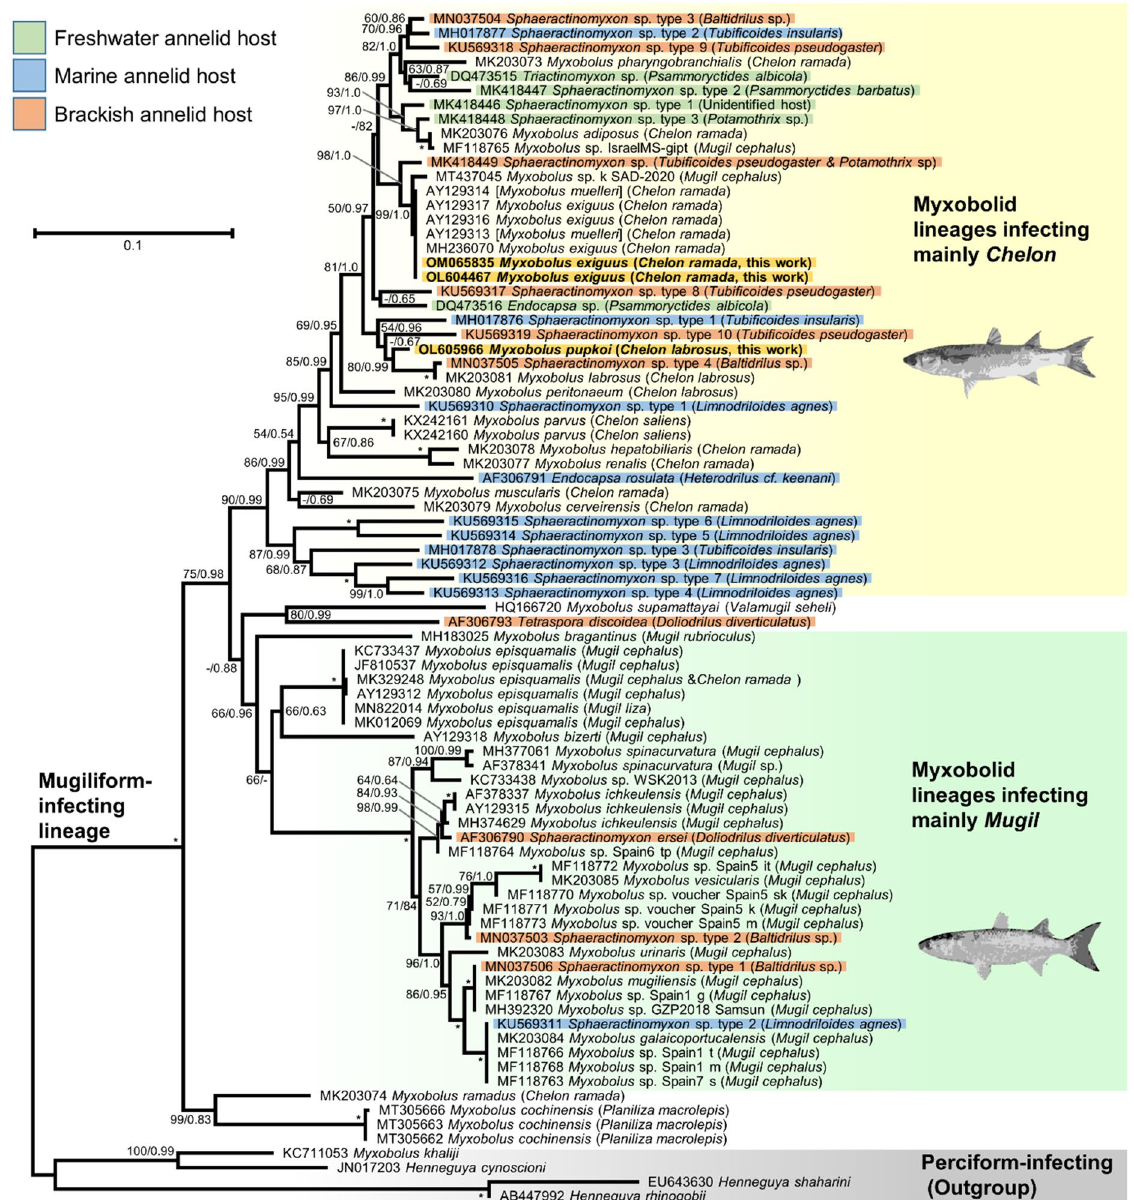
Figure 3. Phylogenetic relationships within the mugiliform-infecting lineage inferred from 18S rRNA sequences under the ML criterion (TVM + F + R3 model). The new sequences of M. exiguus (OL604467 and OM065835) and M. pupkoi (OL605966) are indicated in bold and with a yellow background. Branch supports (i.e. ML bootstrap percentages [BP] above 50/posterior probabilities [PP] above 0.5) are indicated near the corresponding nodes. Maximal support values (BP = 100/PP = 1.0) are indicated by an asterisk. A dash indicates BP < 50 or PP < 0.5. The sequences identified as M. muelleri in NCBI, but recognized to be M. exiguus 10,43 , are indicated within